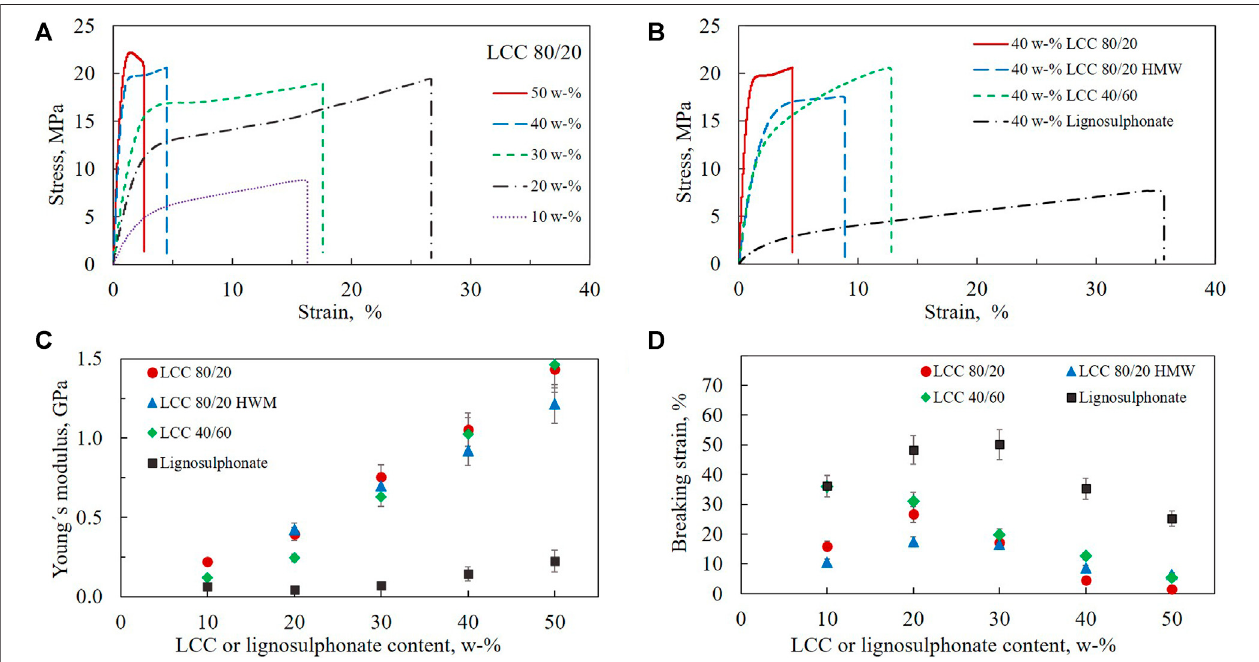
FIGURE 4| Mechanical propertiesof free-standing HEC-based fi lms containingLCCs or lignosulphonate. (A) Stress-strain curves for fi lms containing 10 – 50 w-% LCC 80/20. (B) Stress-strain curves for fi lms containing 40 w-%LCC or lignosulphonate. (C) Young´smodulus of fi lms as afunction ofLCC or lignosulphonate content. (D) Breaking strain of fi lms as a function of LCC or lignosulphonate content. All fi lms contained 5 w-% glycerol and 85 – 45 w-% HEC depending on LCC content.